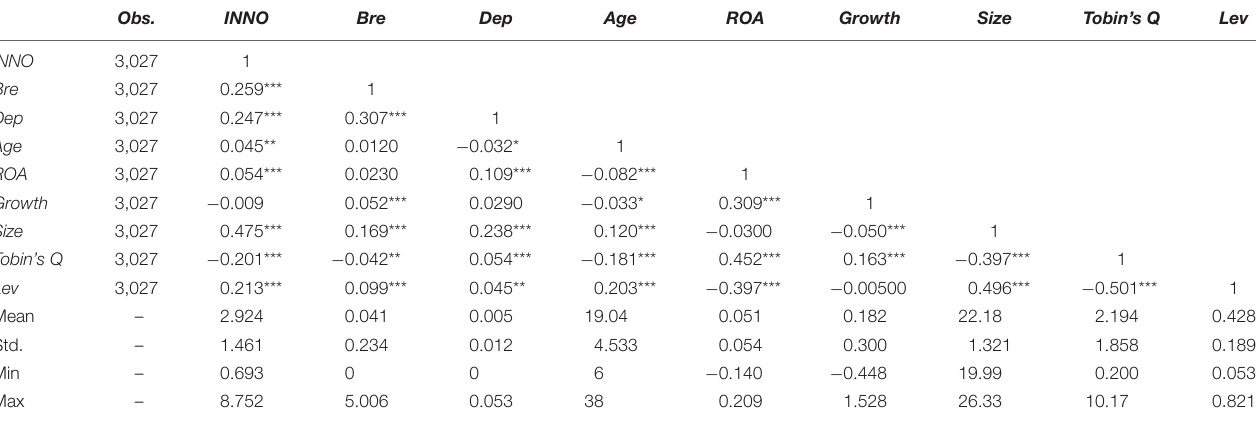
TABLE 1 | Means, standard deviations, and correlations. Obs. INNO Bre Dep Age ROA Growth Size Tobin’s Q